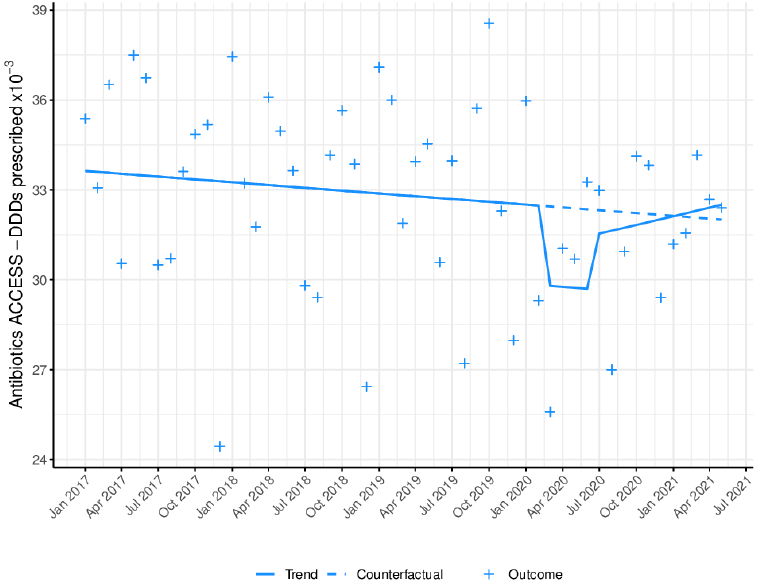
Figure 2. Monthly WHO Access antibiotic prescribing trend in defined daily doses (DDD). Blue line ( − ): trend after model adjustment; blue dashed line: expected trend with no COVID-19 outbreak; +: monthly antibiotic prescriptions in DDD.